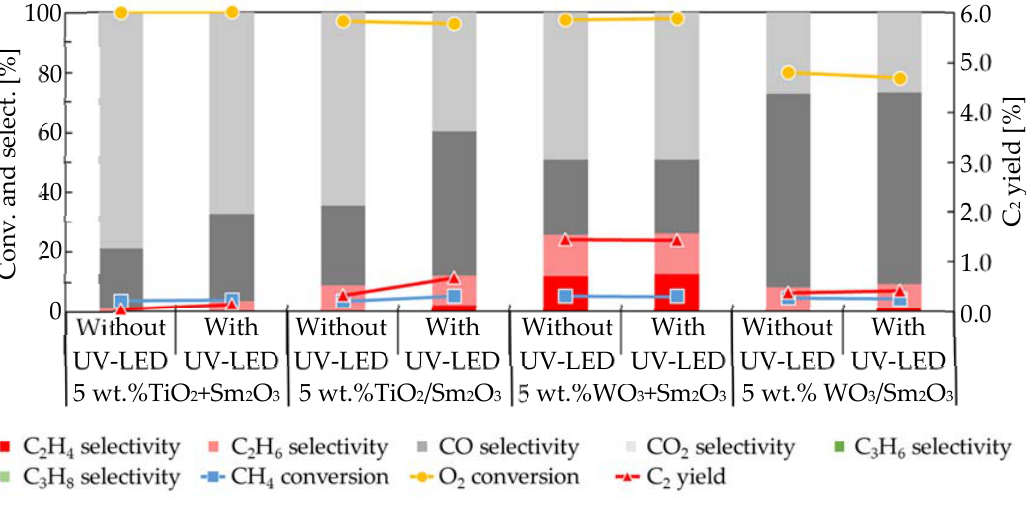
Figure 3. Comparison of the e ff ects of UV-LED irradiation of the oxidative dehydrogenation of methane when using 5 wt.% TiO 2 + Sm 2 O 3 , 5 wt.% TiO 2 / Sm 2 O 3 , 5 wt.% WO 3 + Sm 2 O 3 , and 5 wt.% WO 3 / Sm 2 O 3 .